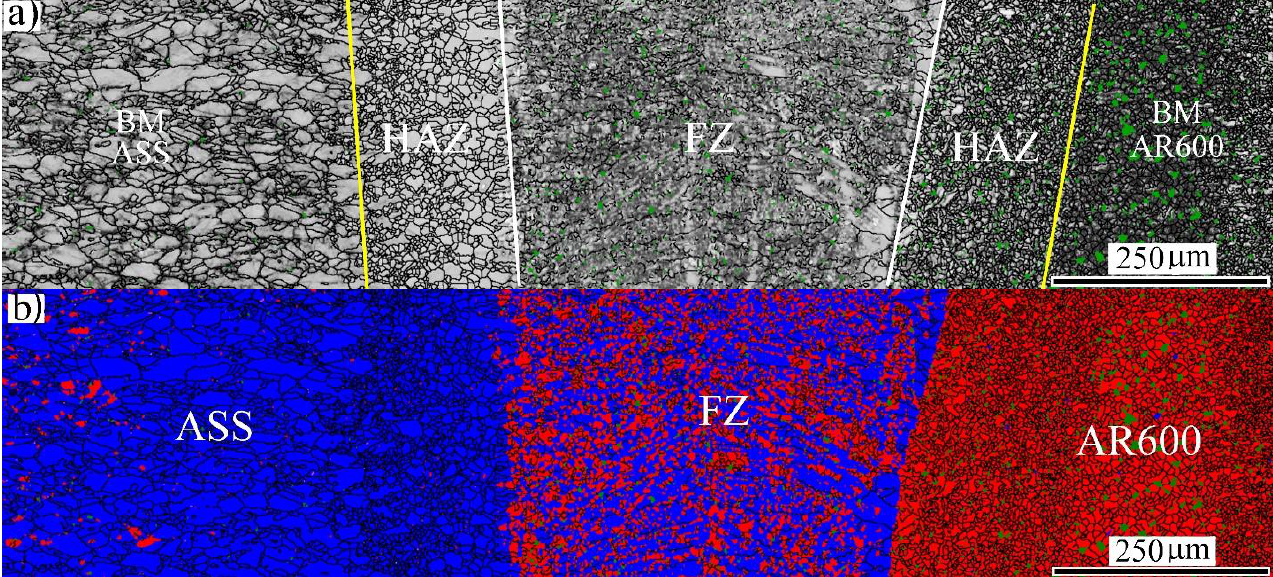
Figure 2. General view of the microstructure across the weld section of the dissimilar laser-welded butt joint at 50 J/mm: ( a ) EBSD-IQ map; ( b ) EBSD phase map with indexing α (cid:48) - bct in red and γ - fcc austenite in blue.